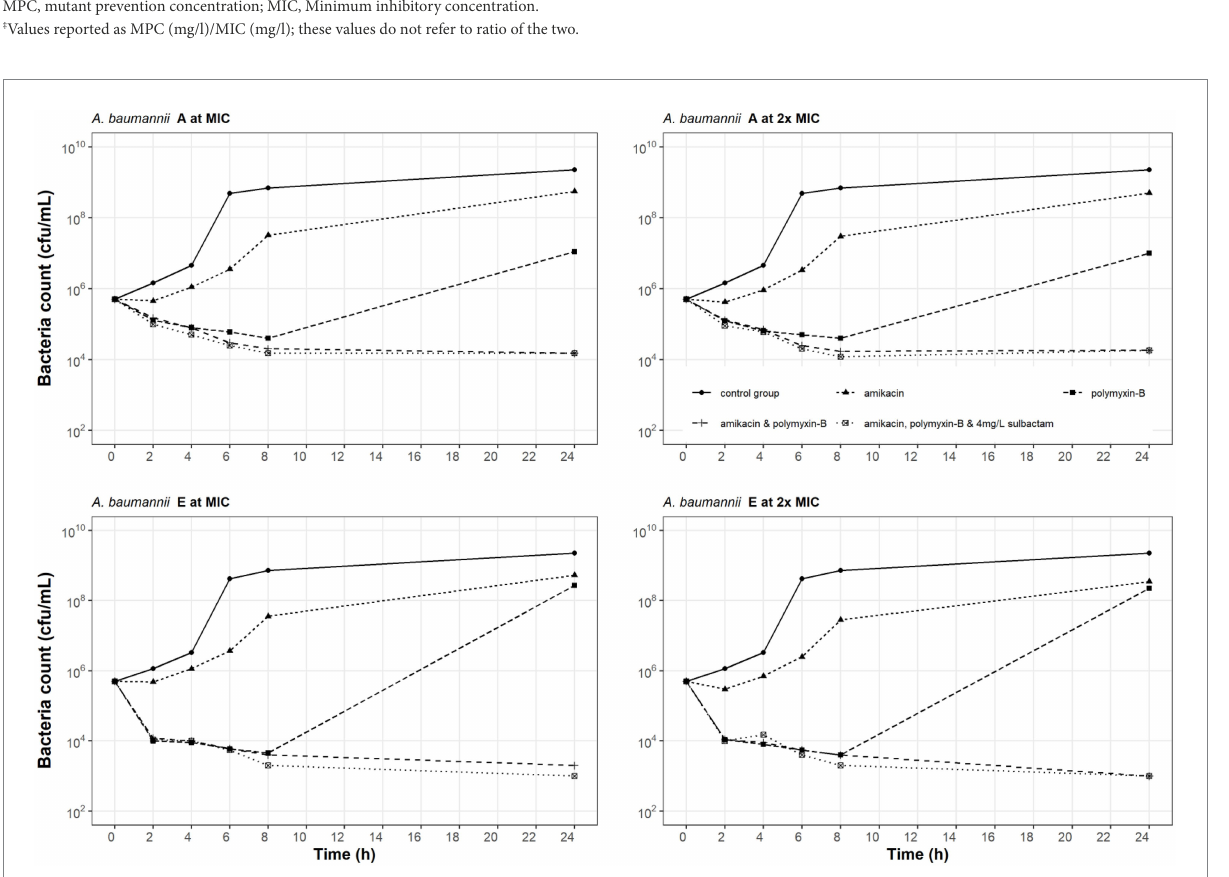
FIGURE 1 Static-concentration time-kill kinetics of amikacin and polymyxin-B alone and in combination at their respective MIC and 2 × MIC and also as triple combination with 4 mg/l sulbactam against two Acinetobacter baumannii isolates. Monotherapy MICs for amikacin and polymyxin-B were >128 and 8 mg/l for isolate A, and >128 and 16 mg/l for isolate E; MICs in the double combination were 1 and 4 mg/l for isolate A and 32 and 4 mg/l for isolate E; MICs in the triple combination were 1 and 4 mg/l for isolate A and 1 and 2 mg/l for isolate E,